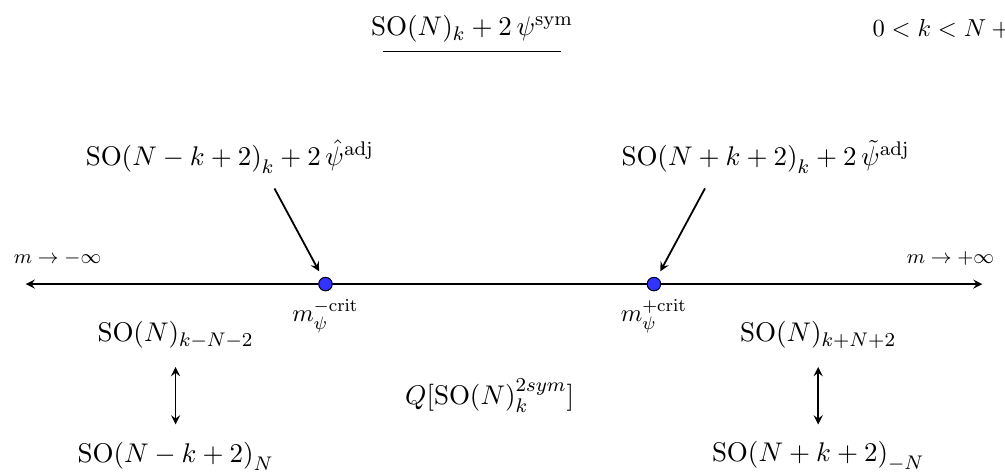
Figure 11 . Phase diagram of SO( N ) with two symmetric-traceless fermions for 0 < k < N + 2. The right dual description is always strongly coupled and left dual description is weakly coupled only when N= 2 (cid:20) k < N +